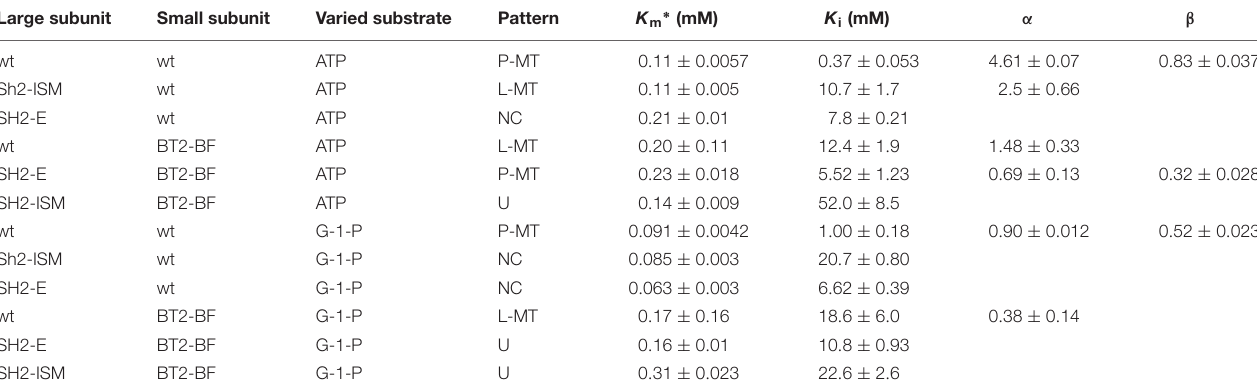
TABLE 5 | Pi inhibition in the presence of 3-PGA of various AGPases. Large subunit Small subunit Varied substrate